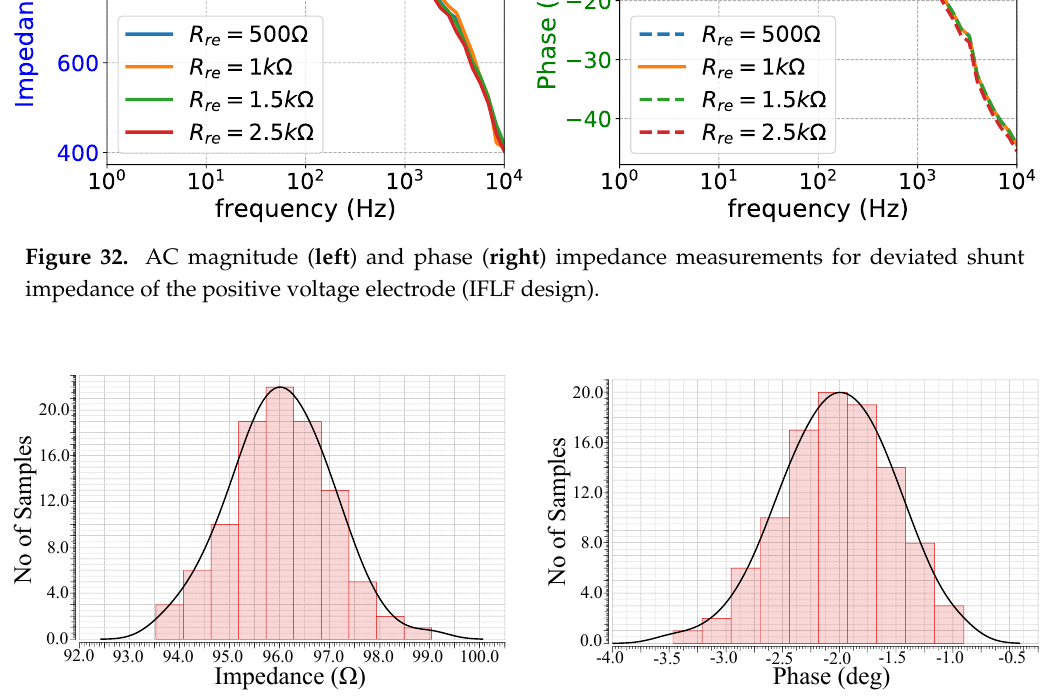
Figure 33. Sensitivity performance of magnitude for target impedance R b = 100 Ω using Monte-Carlo analysis (versatile